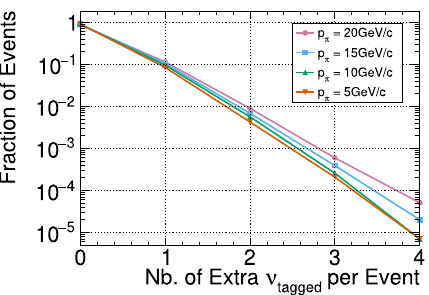
Fig. 4 Distribution of the number of extra tagged neutrinos in coinci- dence with the interacting neutrinos assuming different π ±